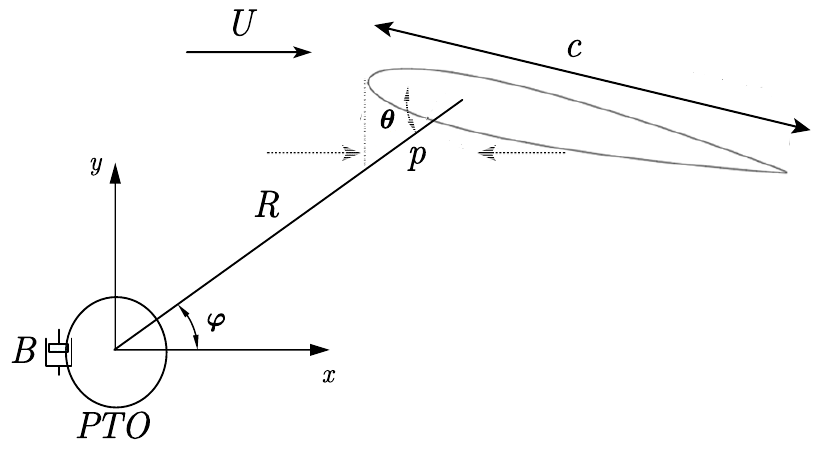
Figure 2. Cross-section of the biomimetic flapping wing operating as steam energy